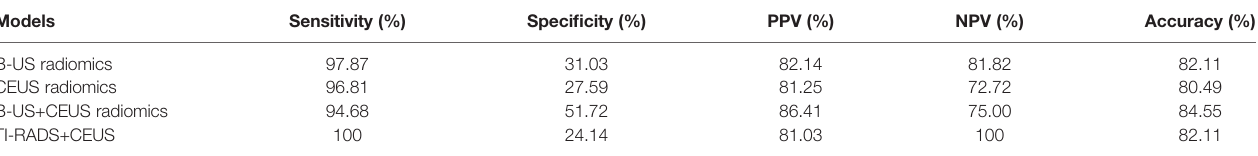
TABLE 5 | Comparison of the diagnostic effectiveness of four types of